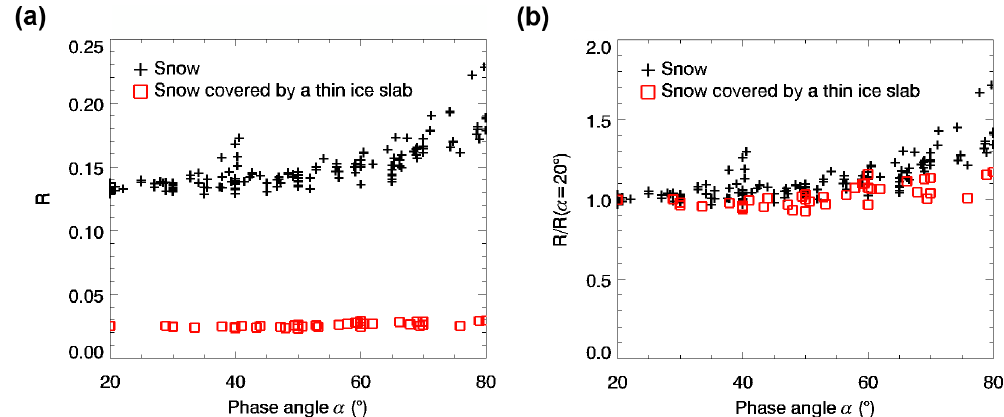
Figure 3. (a) Reflectance factor at a wavelength of λ = 1 . 4µm vs. phase angle for snow only (black crosses) and the same snow but covered with a 1 . 42 ± 0 . 27mm water ice slab (red squares). (b) Same data but normalized by the value at a phase angle α = 20 ◦